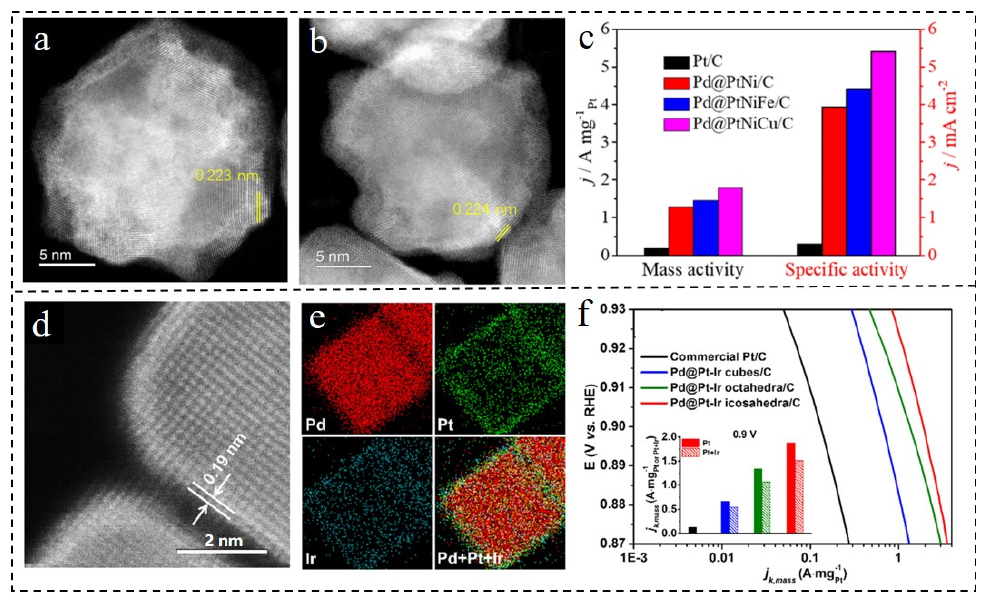
Figure 7. HR-STEM images of ( a ) Pd@PtNiFe NPs and ( b ) Pd@PtNiCu NPs. ( c ) Mass activity and specific activity at 0.9 V RHE of ( a ). Reproduced with permission from [98]. Copyright © 2022, Elsevier. ( d ) Atomic-resolution HAADF-STEM images and ( e ) EDX mapping of Pd@PtIr NPs. ( f ) Mass activities of the Pd@PtIr/C catalysts. Reproduced with permission from [99]. Copyright © 2022, Elsevier.